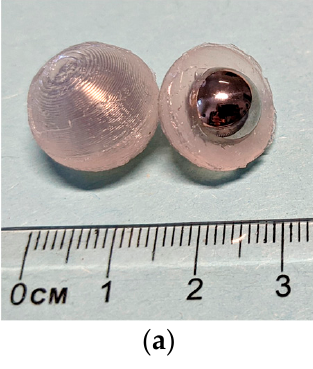
Figure 3. The core-coating inclusion and the oscillations of the core. ( a ) Core-Coating inclusion ( b ) translational oscillation of the core. ( c ) rotational oscillation of the core.